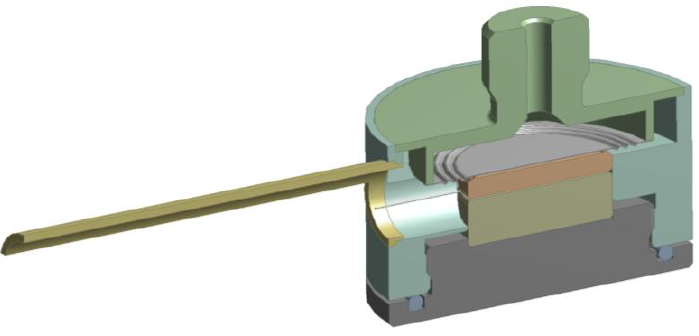
Figure 2. Design pressure sensor that is used for computational model, and subsequently in manufacturing